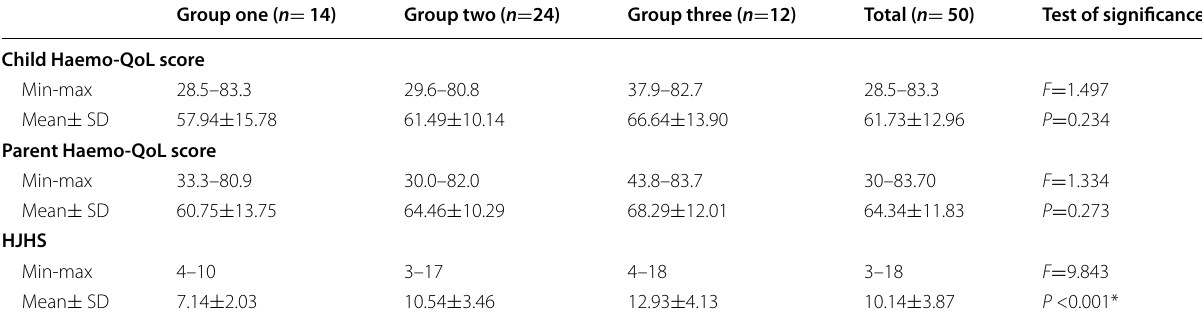
Haemo-QoL Haemo quality of life, HJHS Hemophilia Joint Health Score *Statistically significant at P ≤